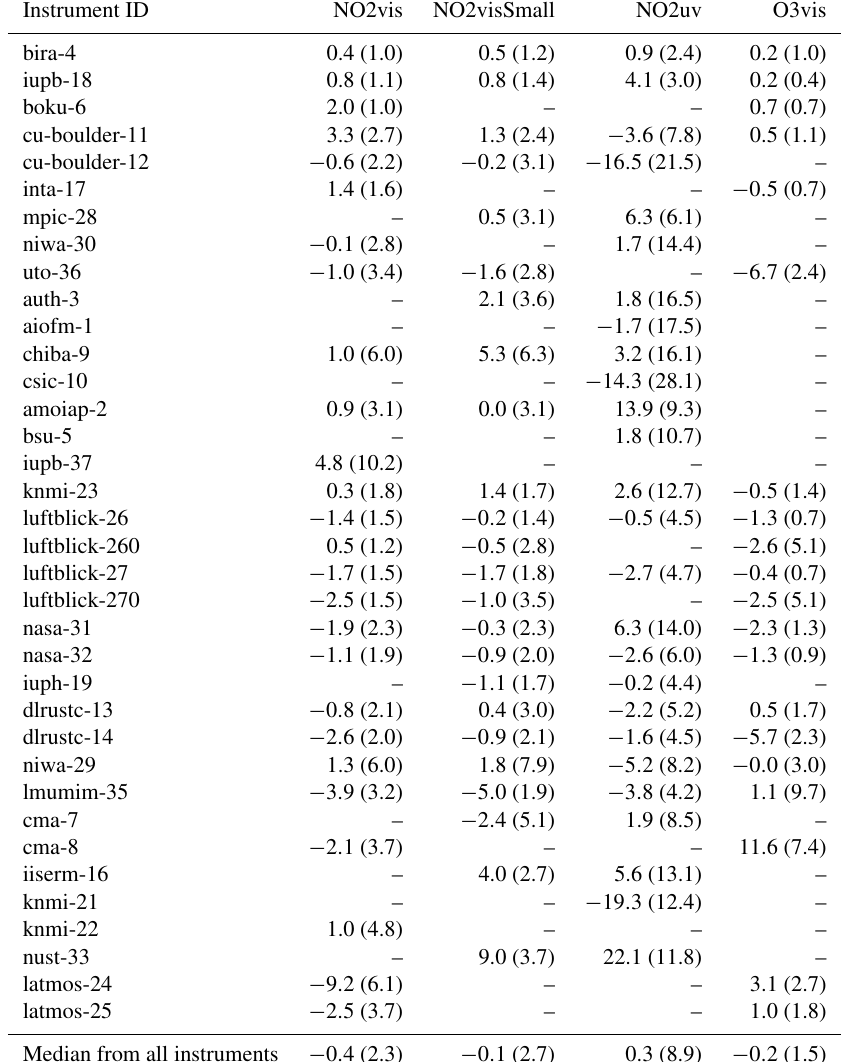
Table 6. Mean relative difference from the reference and standard deviation (in percent) for all participating instruments and zenith-sky DOAS data